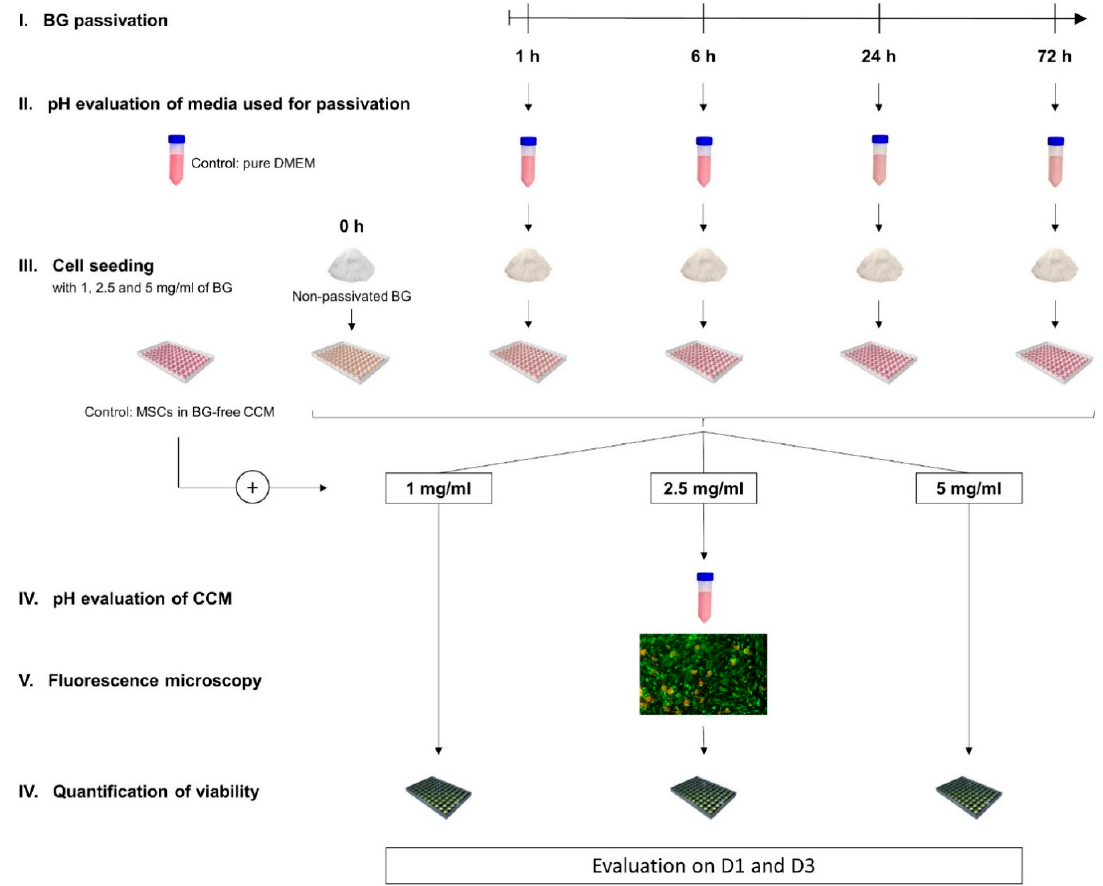
Figure 1. Schematic overview of the experimental design. Bioactive glass (BG) granules were passivated for 1, 6, 24, and 72 h respectively. pH values of the Dulbecco's Modified Eagle's Medium (DMEM) used for passivation were measured. Passivated BGs and non-passivated BGs (0 h) at different concentrations were co-cultured with human bone marrow-derived mesenchymal stromal cells (BMSCs) while cells in BG-free cell culture medium (CCM) served as control. On day 1 (D1) and day 3 (D3) the average BG concentration was used for pH evaluation and microscopical analysis of cell growth patterns, whereas a quantification of cell viability in all groups was performed at BG concentrations of 1, 2.5, and 5 mg/ml.